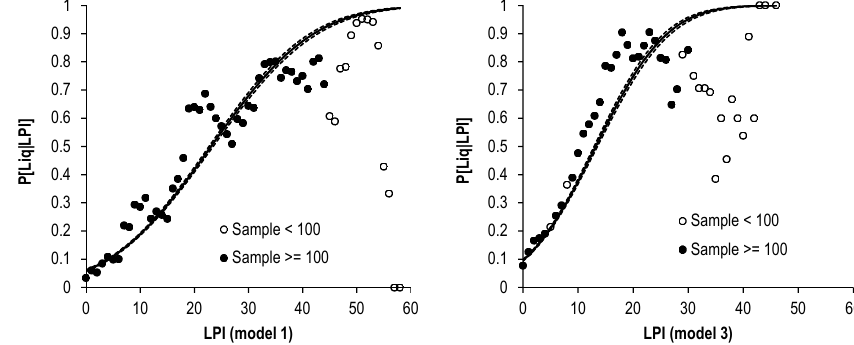
Figure 8. Plots of liquefaction probability against liquefaction potential index (LPI) derived from site-specific observations by generalized linear model with probit link function for two best-performing LPI models. Plots also display the observed liquefaction rates at each LPI value and classified by sample